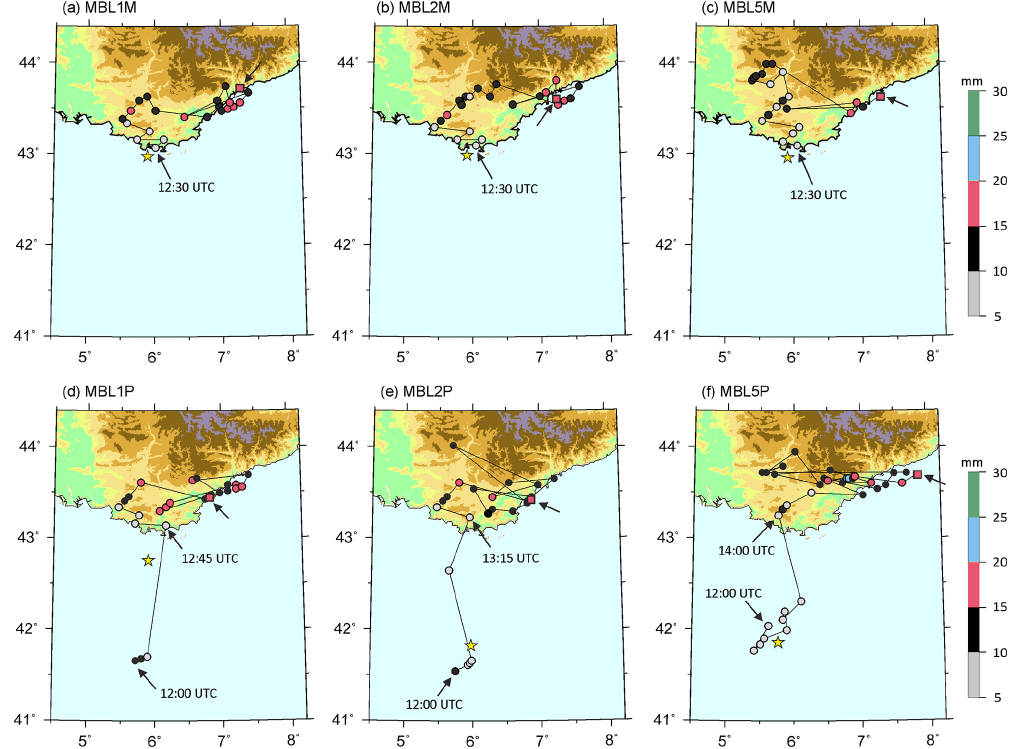
Figure 8. Evolution of the location of the maximum 15min accumulated rainfall for 6h (every 15min from 12:00UTC on 14 October 2012) simulated by (a) MBL1M, (b) MBL2M, (c) MBL5M, (d) MBL1P, (e) MBL2P, and (f) MBL5P. Also shown is the topography (see Fig. 1 for the scale). The location of first convection initiation is marked by a yellow star, and the last precipitating point at 18:00UTC is marked by a square with an arrow pointing to it.